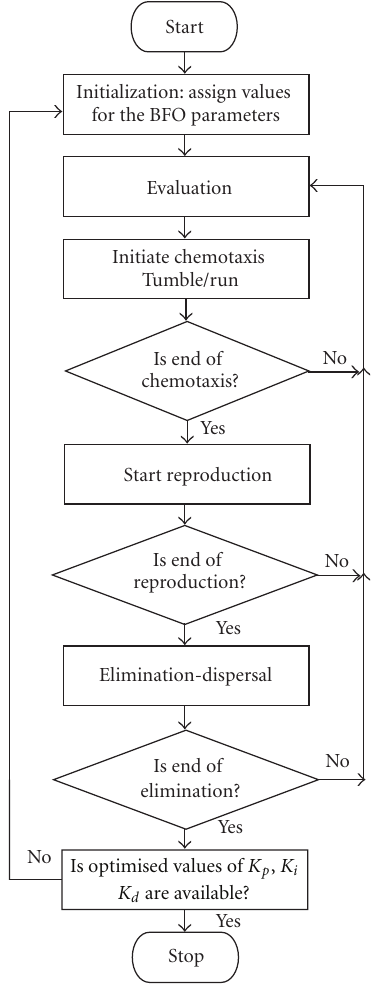
Figure 1: Flow chart for bacterial foraging algorithm.